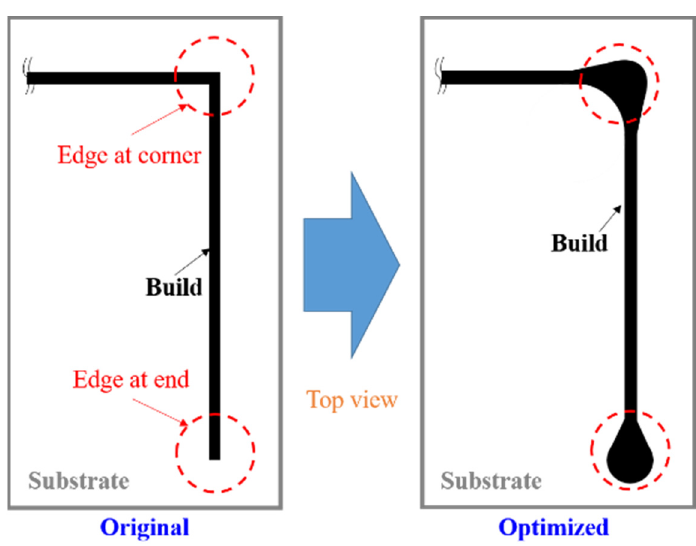
Figure 14. Proposed modification of the local stiffness of thin-walled structures.